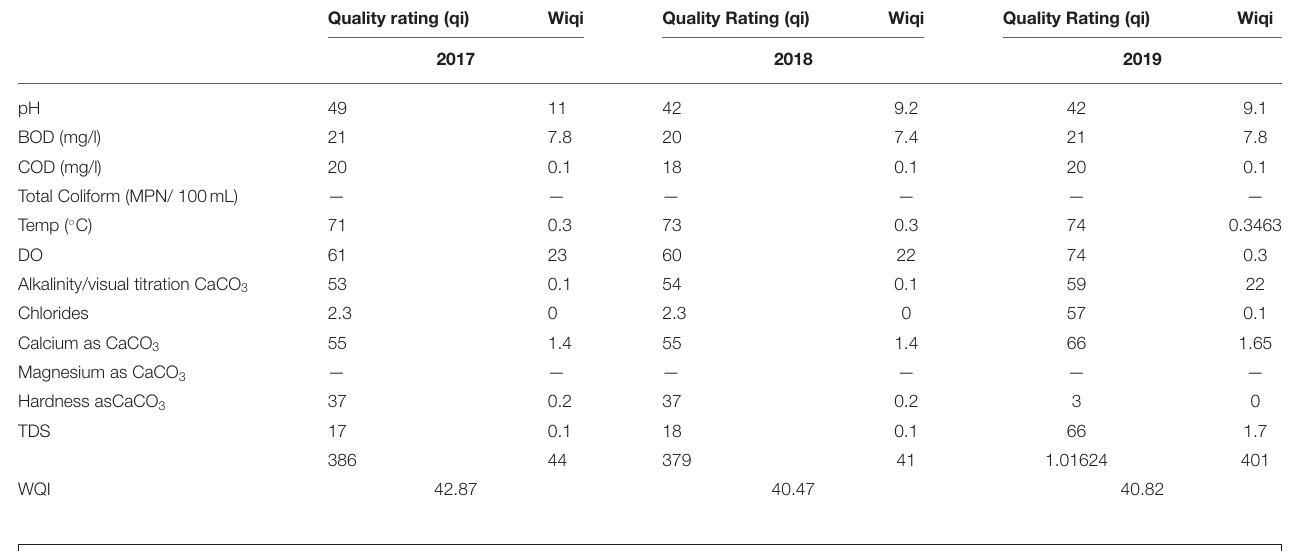
TABLE 6 | Water quality index (WQI) for Yamuna river at Dehradun for 2017, 2018, and 2019.